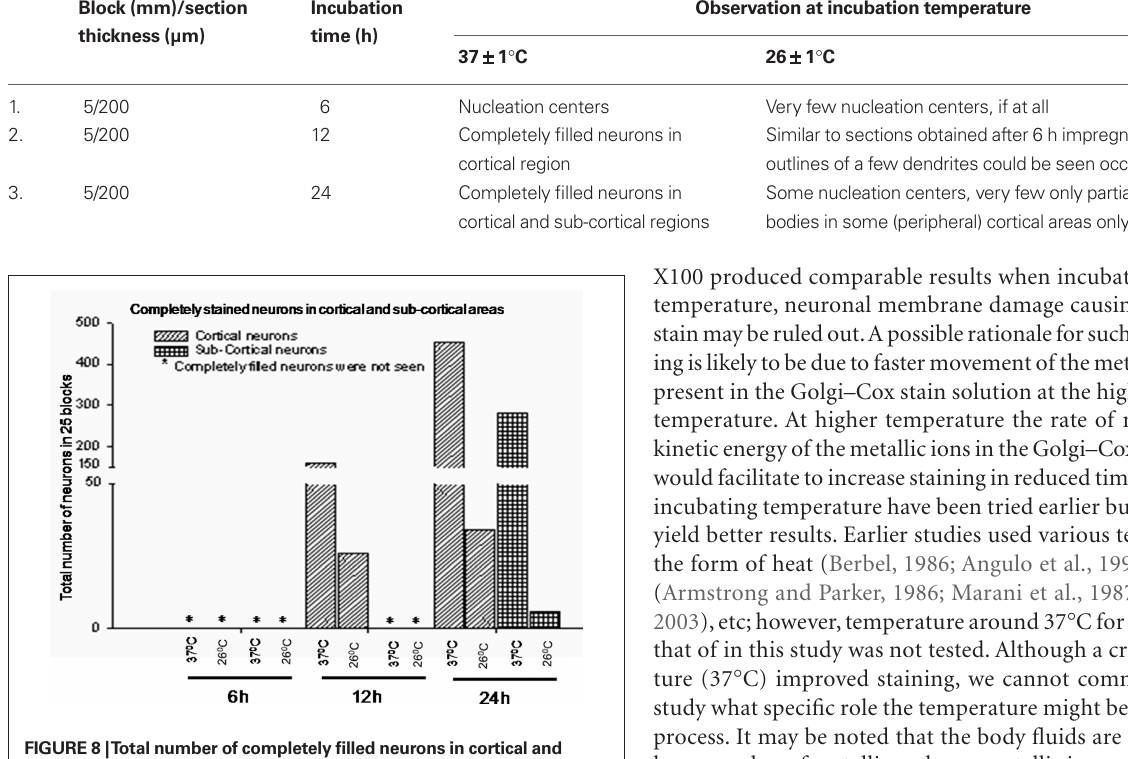
FIGure 8 | Total number of completely filled neurons in cortical and sub-cortical brain areas in 26 ± 2 frames (as described in text) after incubation of the brain blocks at 37 ± 1 ° C and 26 ± 1 ° C for 6, 12, and 24 h are